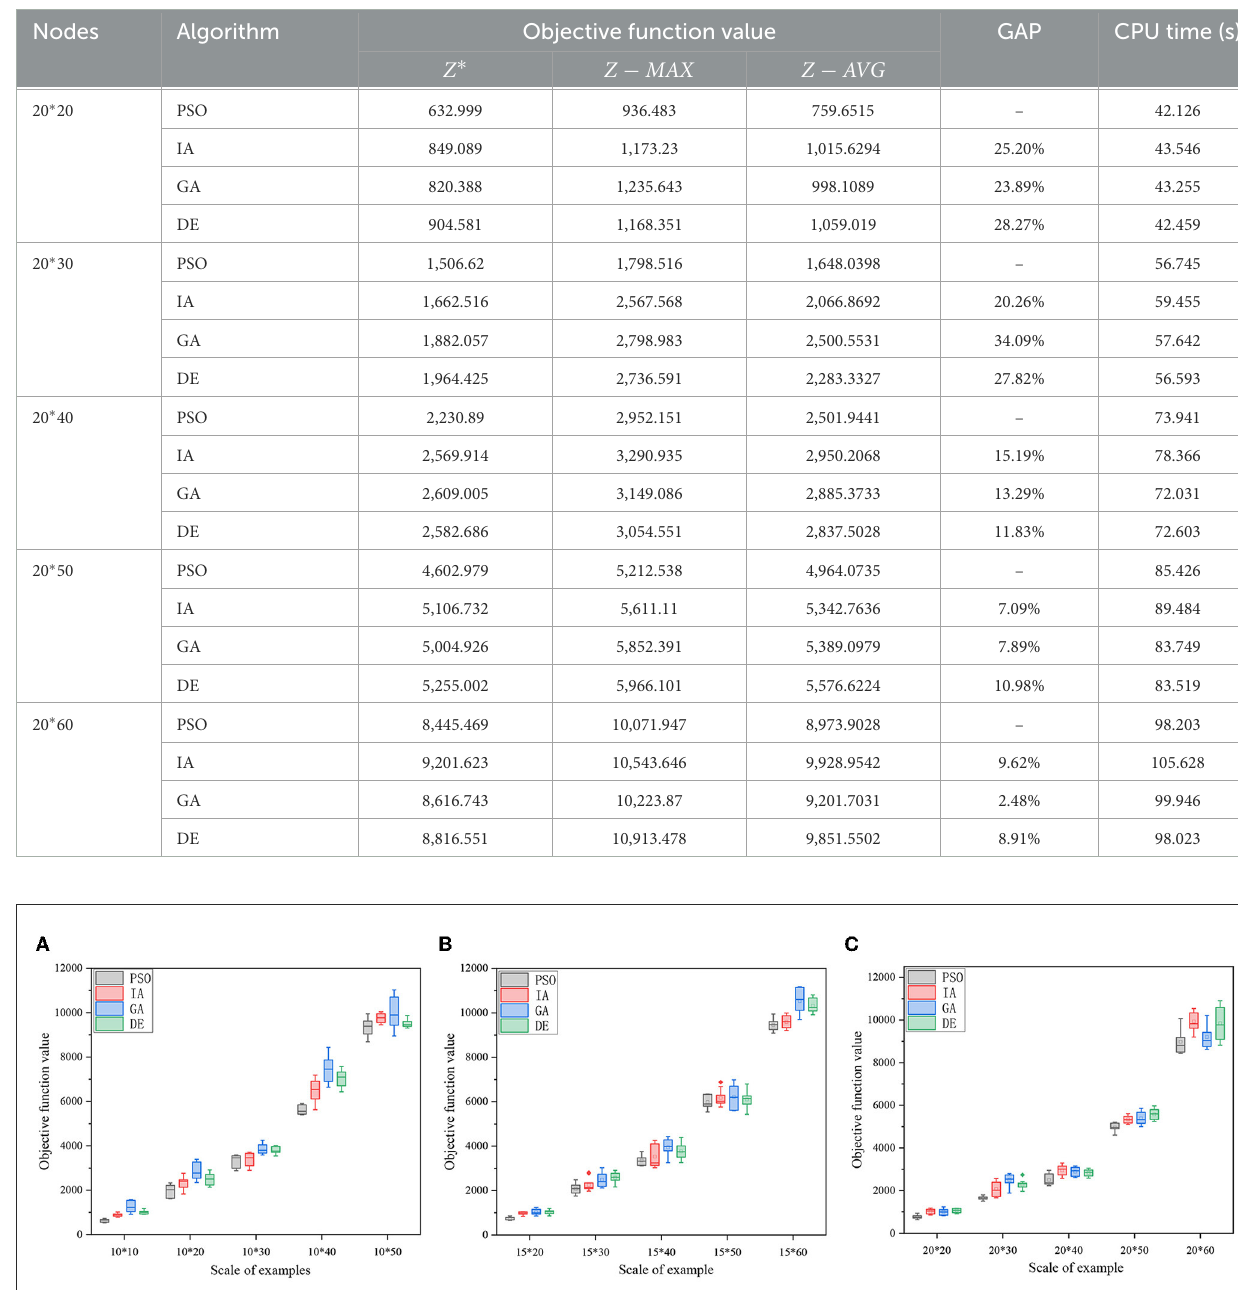
FIGURE7 (A) Box diagram of group 1. (B) Box diagram of group 2. (C) Box diagram of group